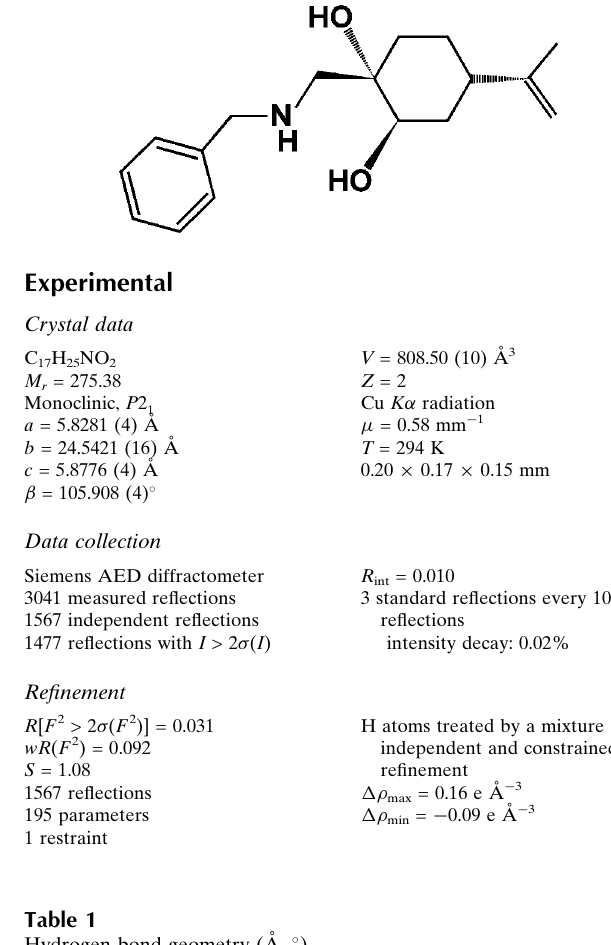
Hydrogen-bond geometry (A˚ , (cid:3)